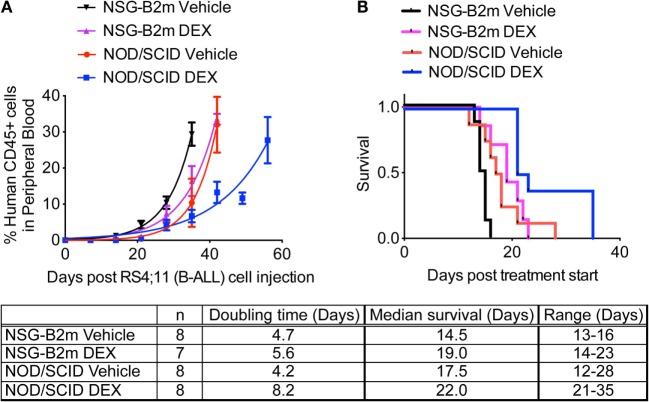
NSG-B2m model system is suitable for drug testing. NOD/SCID or NSG-B2m mice were injected with RS4;11 cells. When the median percentage of CD45+ cells in mouse peripheral blood reached above 1%, mice were randomized into two groups and treated with either vehicle or 15 mg/kg dexamethasone (M-F). (A) Growth curves showing the rise in percentage of human CD45+ cells. (B) Kaplan–Meier survival plots showing the survival of NSG-B2m or NOD/SCID mice following transplantation with RS4;11.